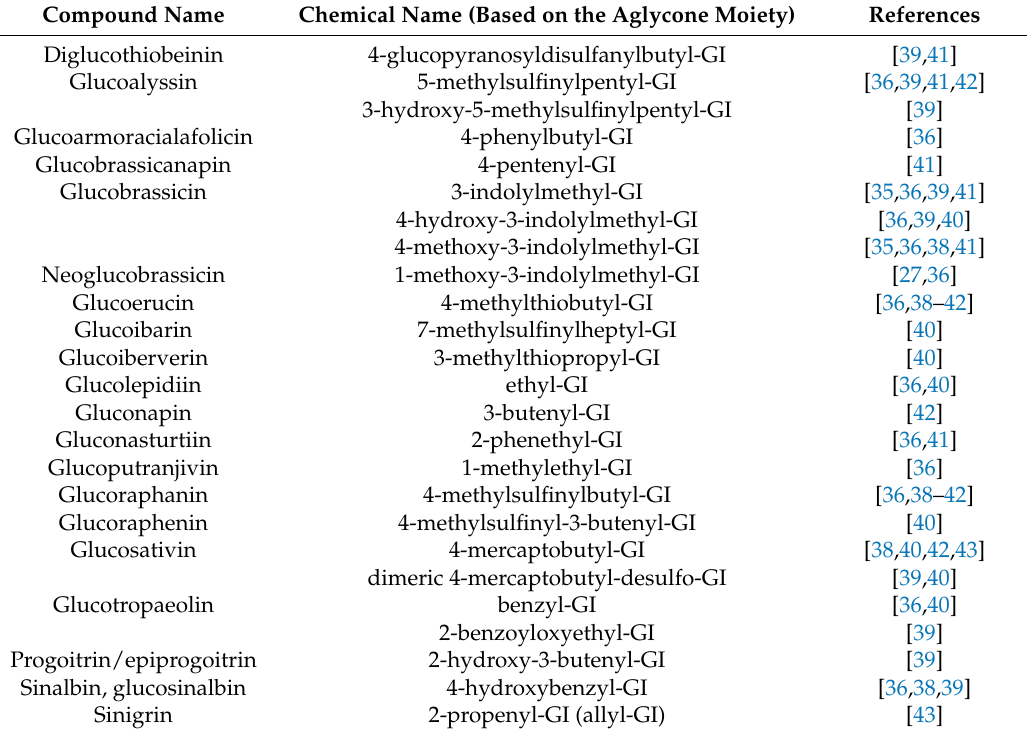
Table 1. Glucosinolates (GI) reported from D. tenuifolia